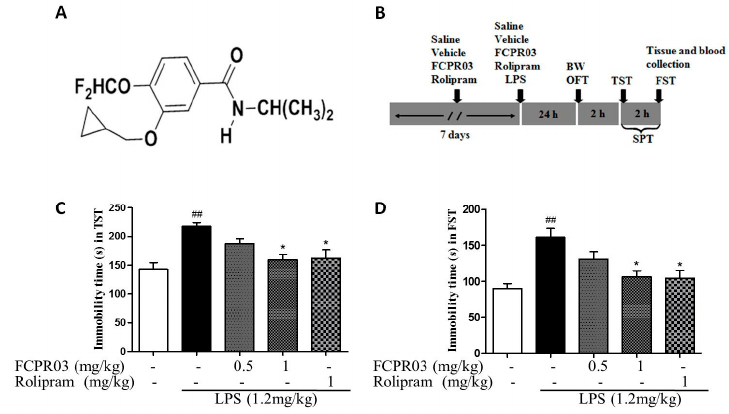
Figure 2. Effect of pre-treatment of mice with FCPR03 or rolipram on the LPS-induced reductions in the immobility time in the tail suspension test and forced swimming test. The chemical structure of FCPR03 ( A ) and experimental time line ( B ). After seven consecutive days of pretreatment with FCPR03 (0.5 mg/kg or 1 mg/kg) or rolipram (1 mg/kg), mice were injected i.p. with saline or LPS (1.2 mg/kg, i.p.); 24 h after LPS injection, the immobility time in tail suspension test ( C ) and forced swimming test ( D ) were measured. Data are expressed as the mean ± SEM, ## p < 0.01 compared with control group; * p < 0.05 compared with LPS group ( n = 8 per group). BW, body weight; OFT, open field test; TST, tail suspension test; FST, forced swimming test; SPT, sucrose preference test.